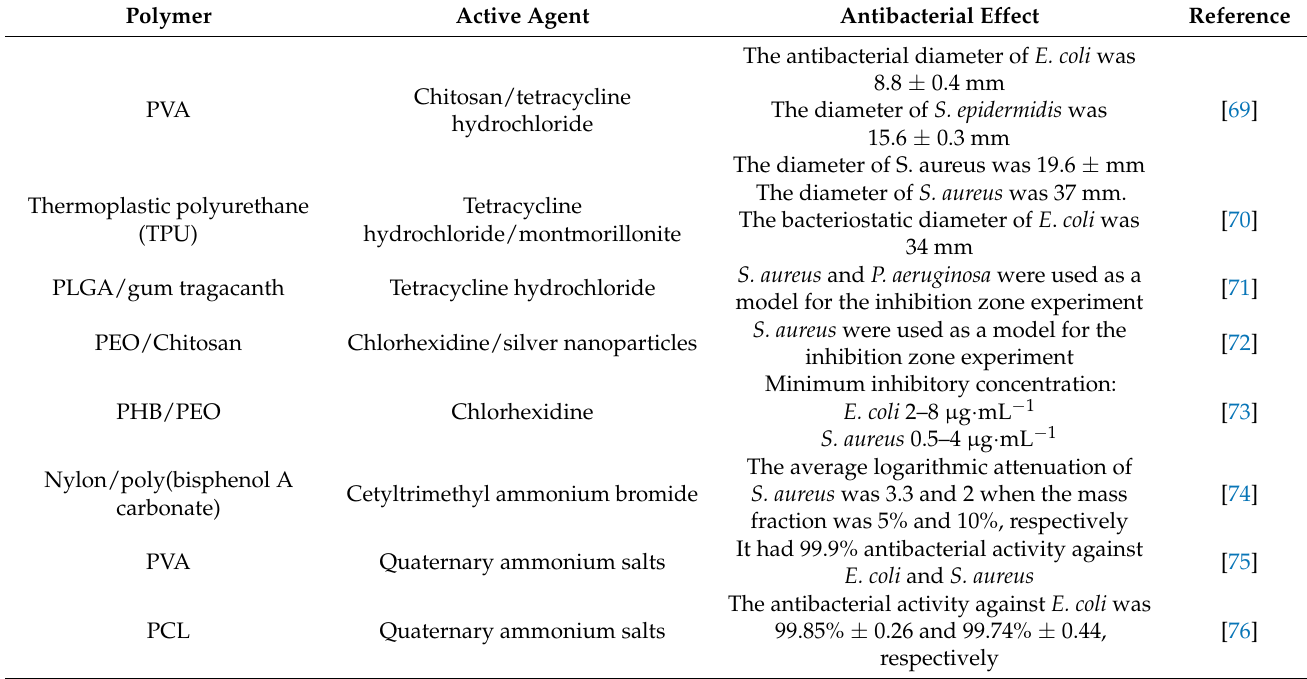
Table 1. Applications of organic antibacterial agents in